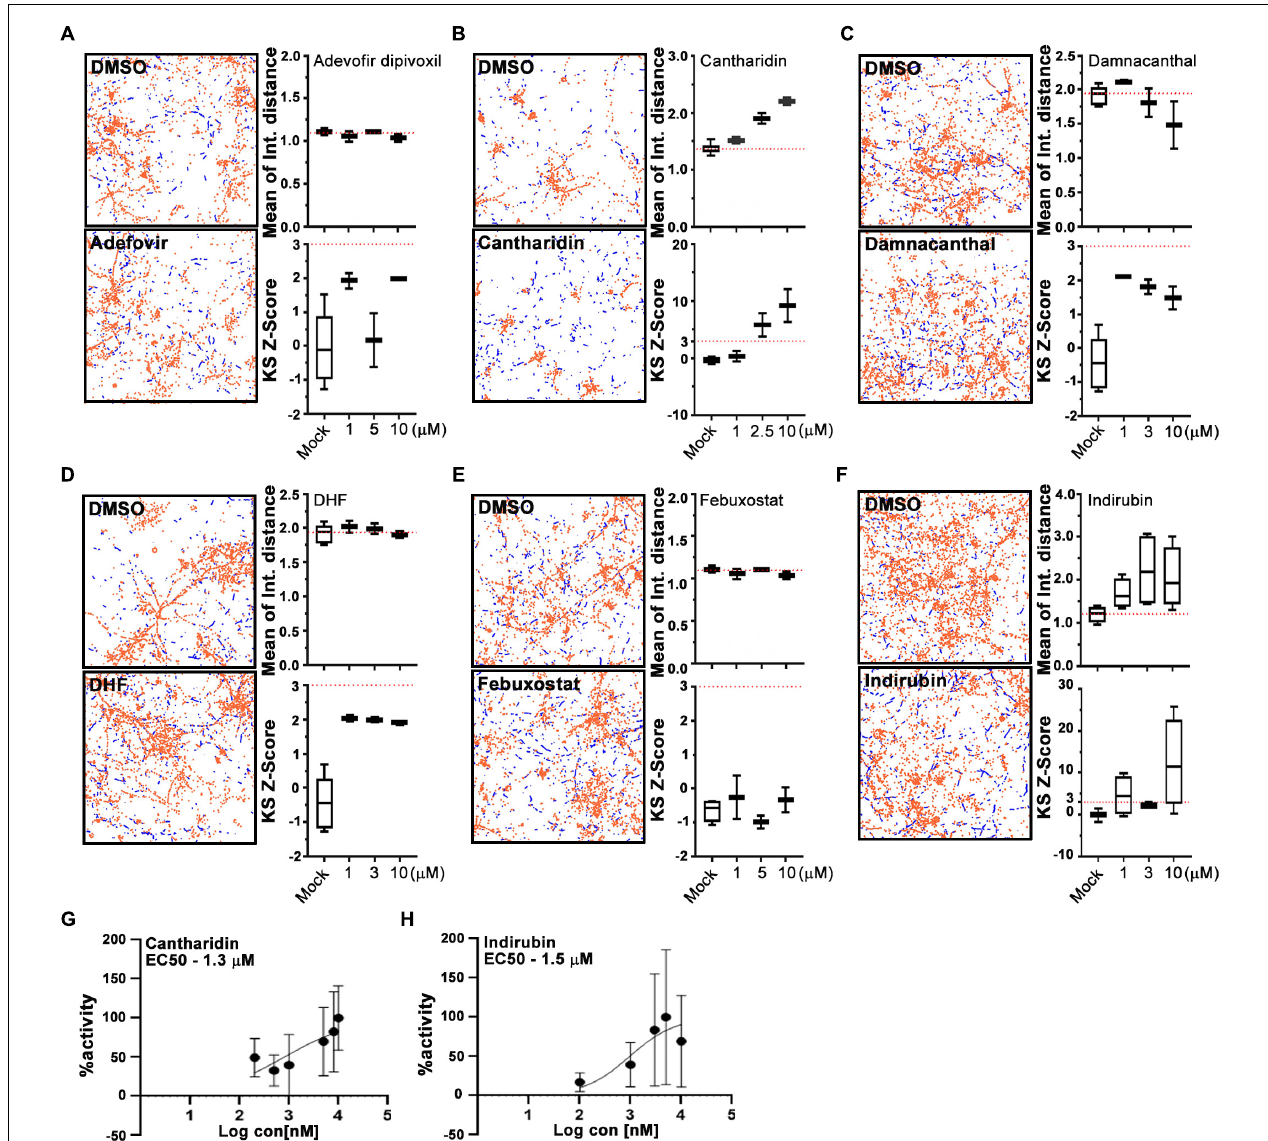
FIGURE 2 | Cantharidin and indirubin enhance mitochondrial movement. (A–F) Representative fields with tracking of mitochondria as analyzed by the PATH algorithm in neurons treated with the indicated test compound and its DMSO control. Stationary mitochondria are red and the tracks of moving mitochondria are blue. From similar traces, and using three concentrations of each compound, the mean of the integrated distance traveled and the KS2 Z -score are shown to the right of each pair of traces. Dashed lines indicate the average value of integrated distance in control (DMSO) neurons and a Z -score of 3, the threshold used to select hits. (G,H) Dose-response curves of mitochondrial motility (integrated distance traveled) for cantharidin and indirubin plotted as the % maximum activity against the log of the concentration. Tukey’s box plots; error bars represent SD. All experiments were done in three replicates from different animals. In each of those replicates, four wells were imaged per condition, each well containing 30,000